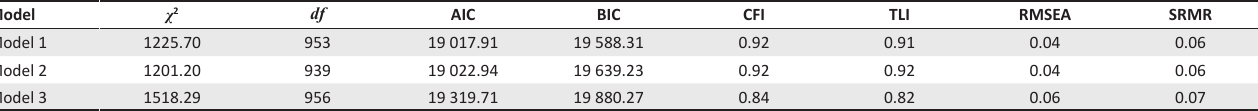
Reliabilities of the Big Five personality traits ranged from 0.60 to 0.7. The composite reliability coefficient for the TW measure was 0.9, with p = 0.9 for the ability subscale, p = 0.88 for the benevolence subscale and p = 0.76 for the integrity subscale. The TB (disclosure) scale reported a p -value of 0.9. TABLE 1: Fit statistics of competing measurement models .